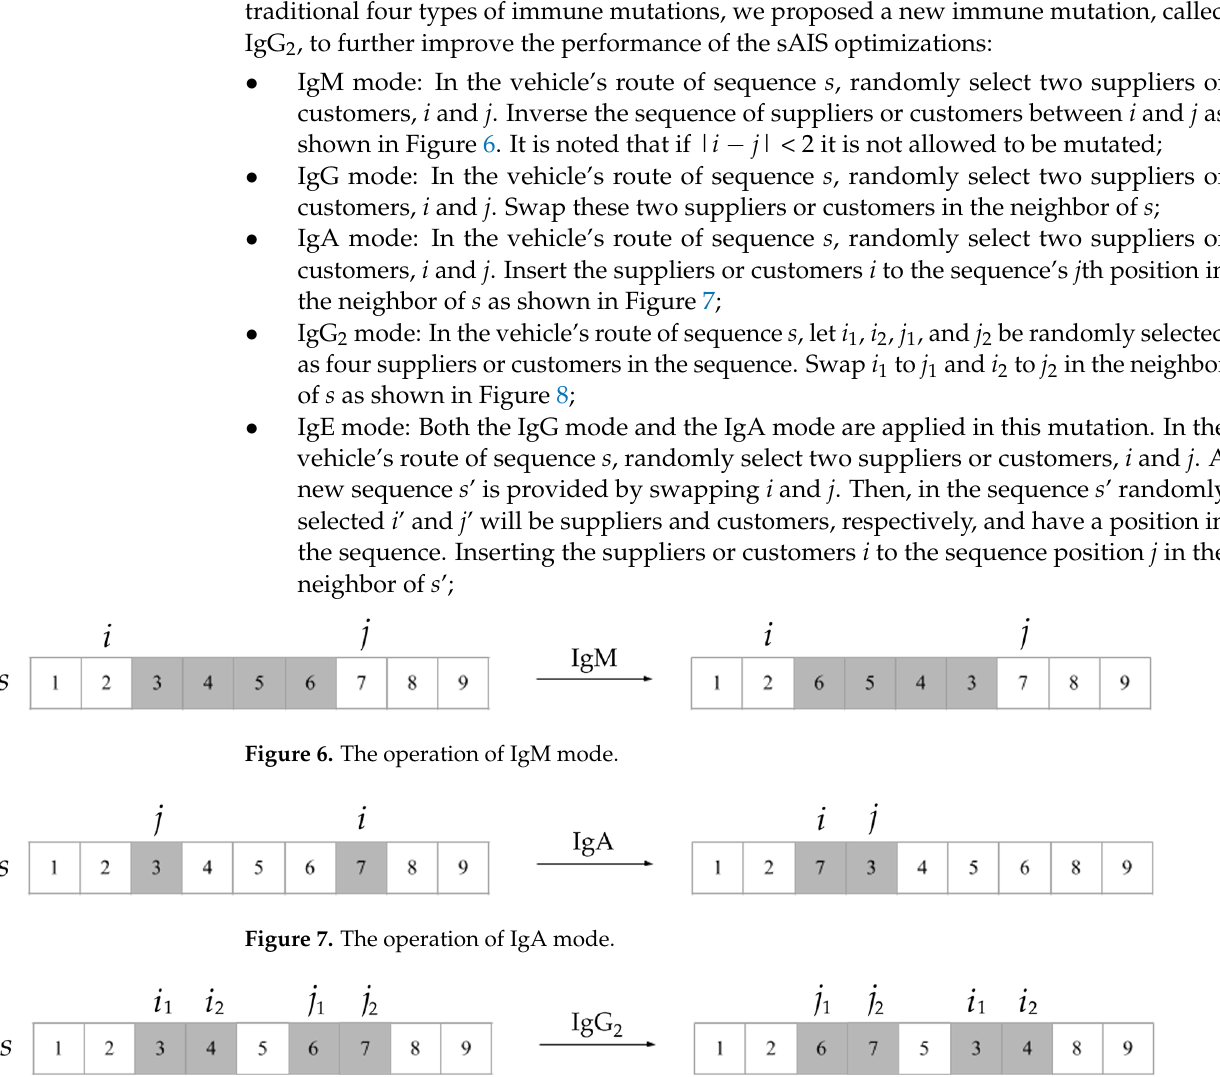
Figure 8. The operation of IgG 2 mode. 